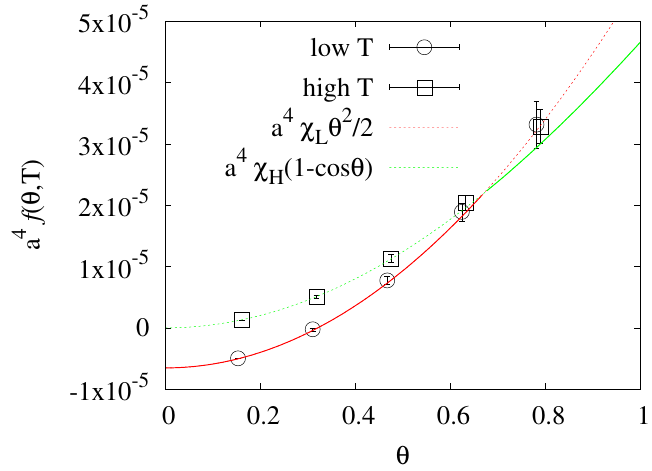
Figure 13 . The θ dependence of the free energy density. The numerical data are obtained at β = 2 . 510 . The expected behaviors in the low and high T phases, a 4 χ L θ 2 / 2 and a 4 χ H (1 − cos θ ) , are shown as a guide to